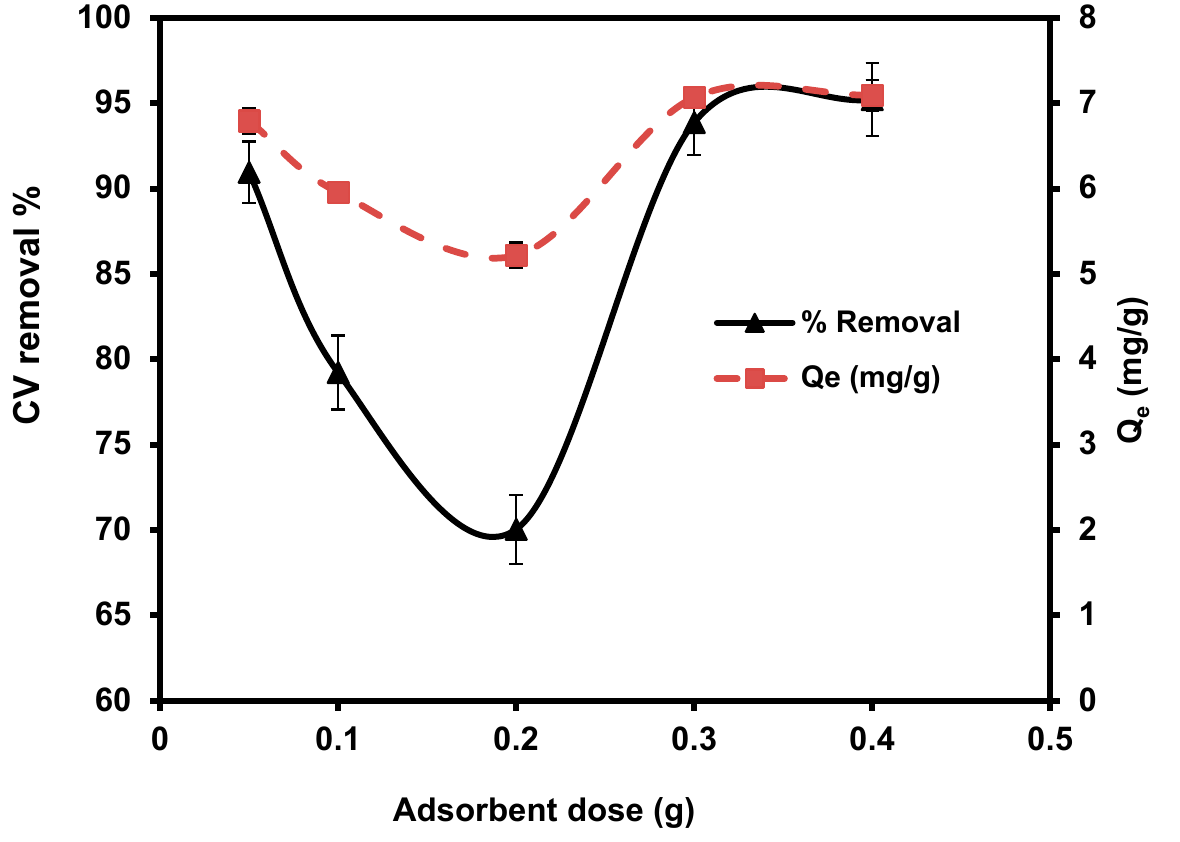
Figure 6. Impact of S. costatum concentrations on the adsorption of CVD.